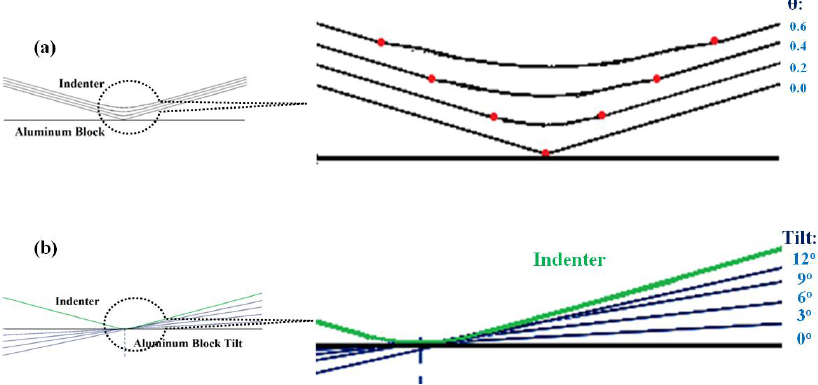
Figure 4. Schematic view of various indenter edge-tip radii ( a ), and sample tilts ( b ) in the nanoindentation experiment.